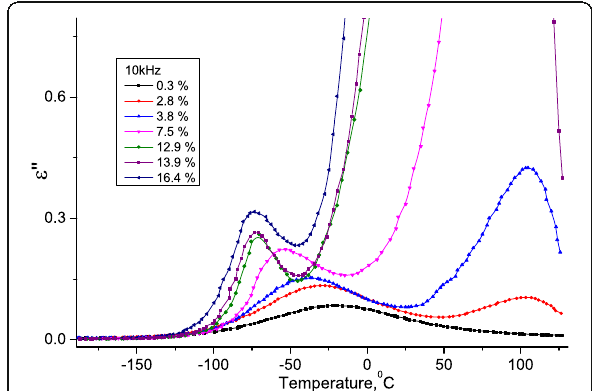
Fig. 13 Temperature dependence of imaginary part of dielectric permittivity for MCC samples with different water content.